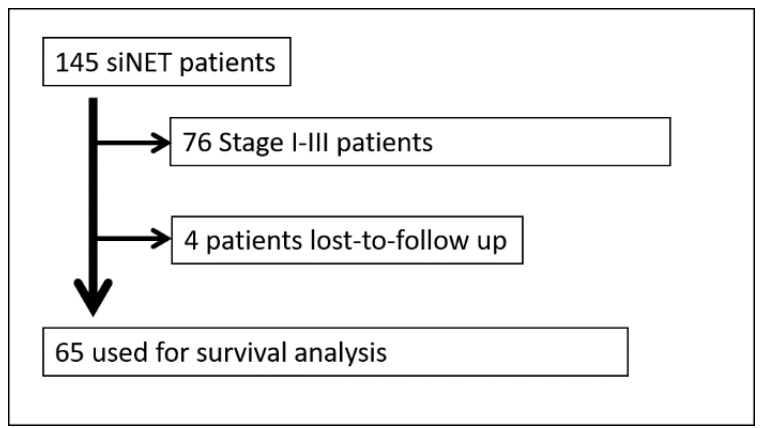
Figure 1. CONSORT diagram.